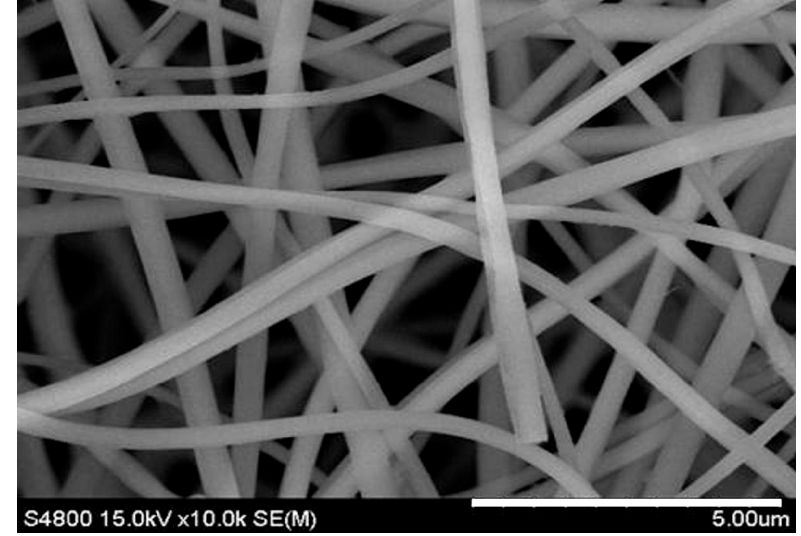
Figure 1. Scanning electron microscopy (SEM) images of mesoporous bioactive glass nanofibers (MBGNFs).